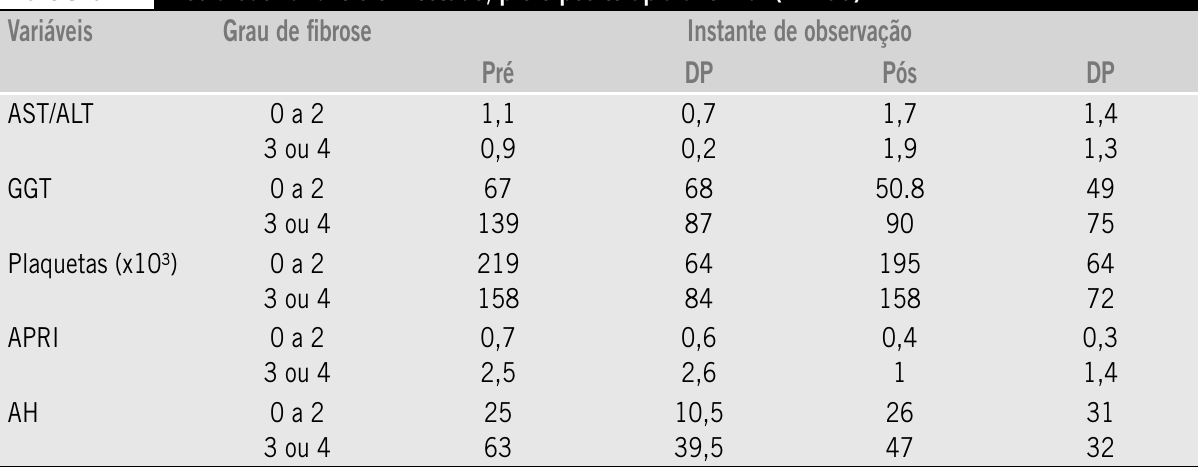
Tabela 4 Média das variáveis em estudo, pré e pós-terapia antiviral ( n = 33)